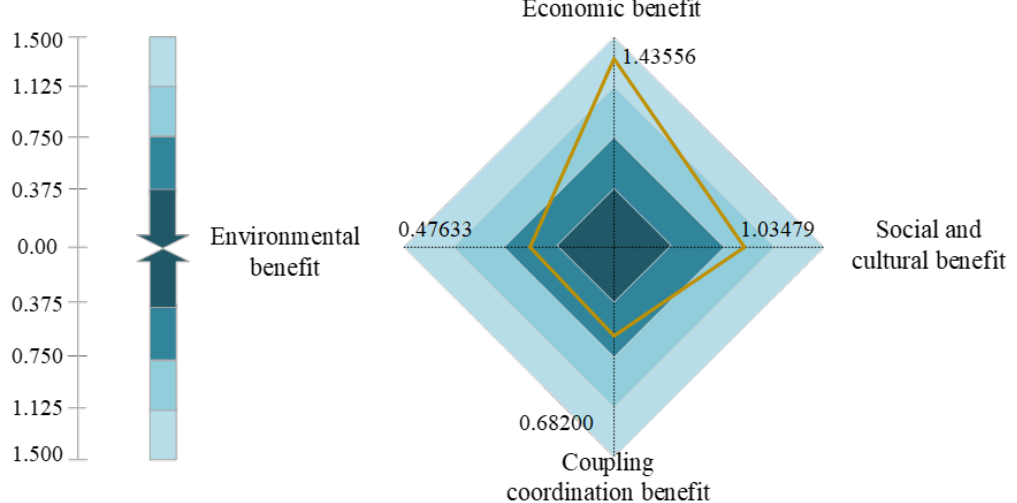
Table 5. The final evaluation value of comprehensive benefit.